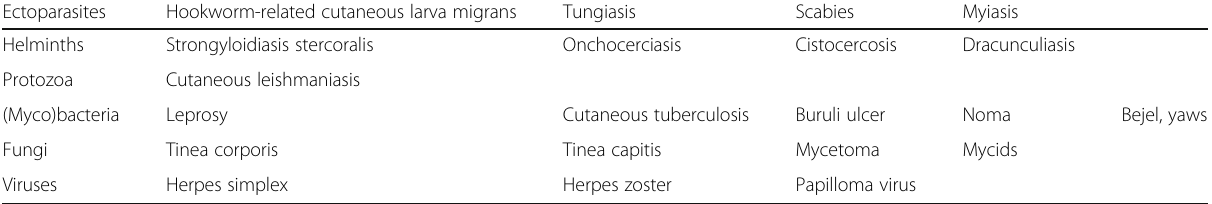
Table 4 Tropical diseases for which HRIT could be used as a tool to measure morbidity and to monitor treatment success